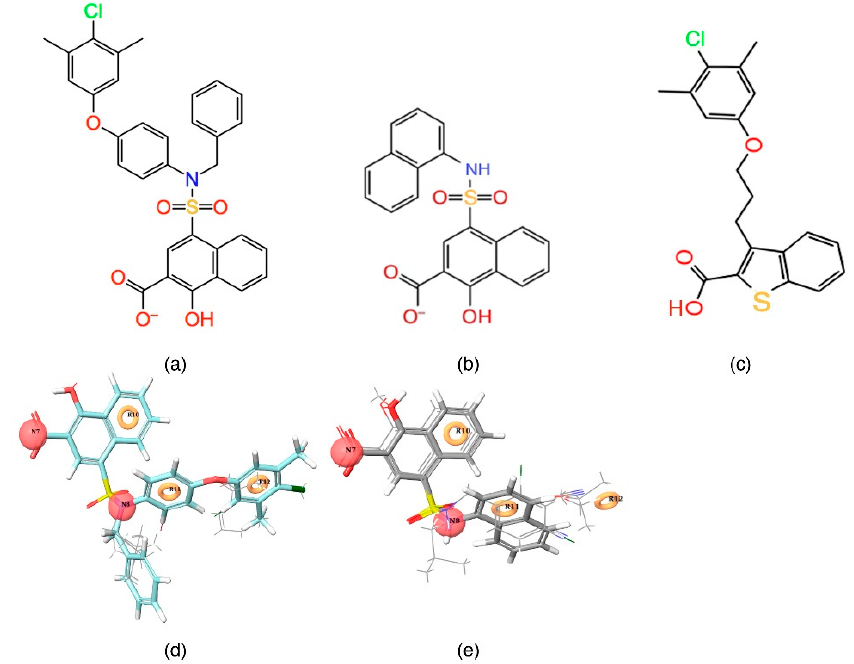
Figure 2. 2D ( a , b ), and 3D ( d , e ) representations of highly active [ C40 —CHEMBL 3781822] and inactive [ C1 —CHEMBL 3780357] compound superposed over a five-point pharmacophore hypothesis. ( c ) A 2D representation of the reference ligand obtained from the PDB ID: 4HW3 structure.